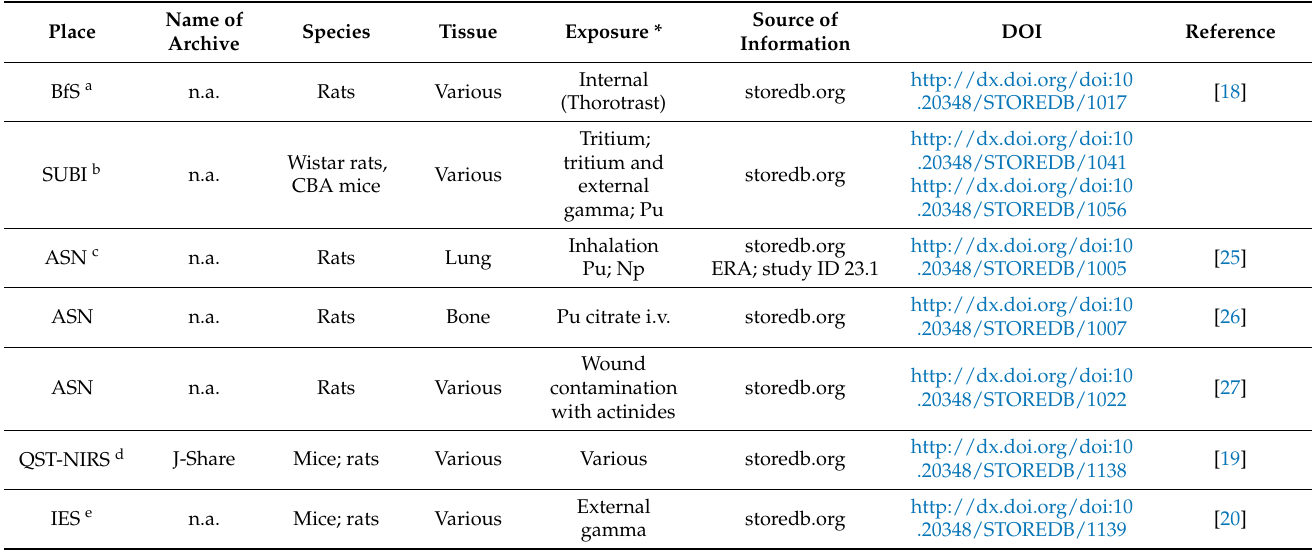
Table 1. The FFPE animal tissue listed in STORE DB and/or available in the radiobiological